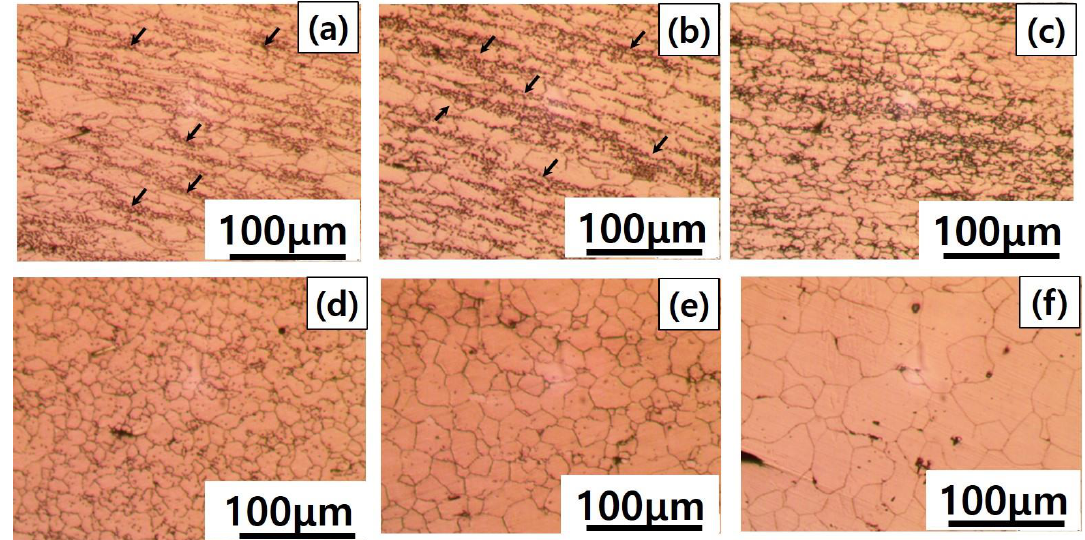
Figure 11. Longitudinal cross sectional views of groove-rolled high-carbon high-nitrogen Fe-Cr-Mn-Ni steels fractured at various temperatures; 850 ◦ C ( a ), 1000 ◦ C ( b ), 1100 ◦ C ( c ), 1150 ◦ C ( d ), 1200 ◦ C ( e ), and 1225 ◦ C ( f ).